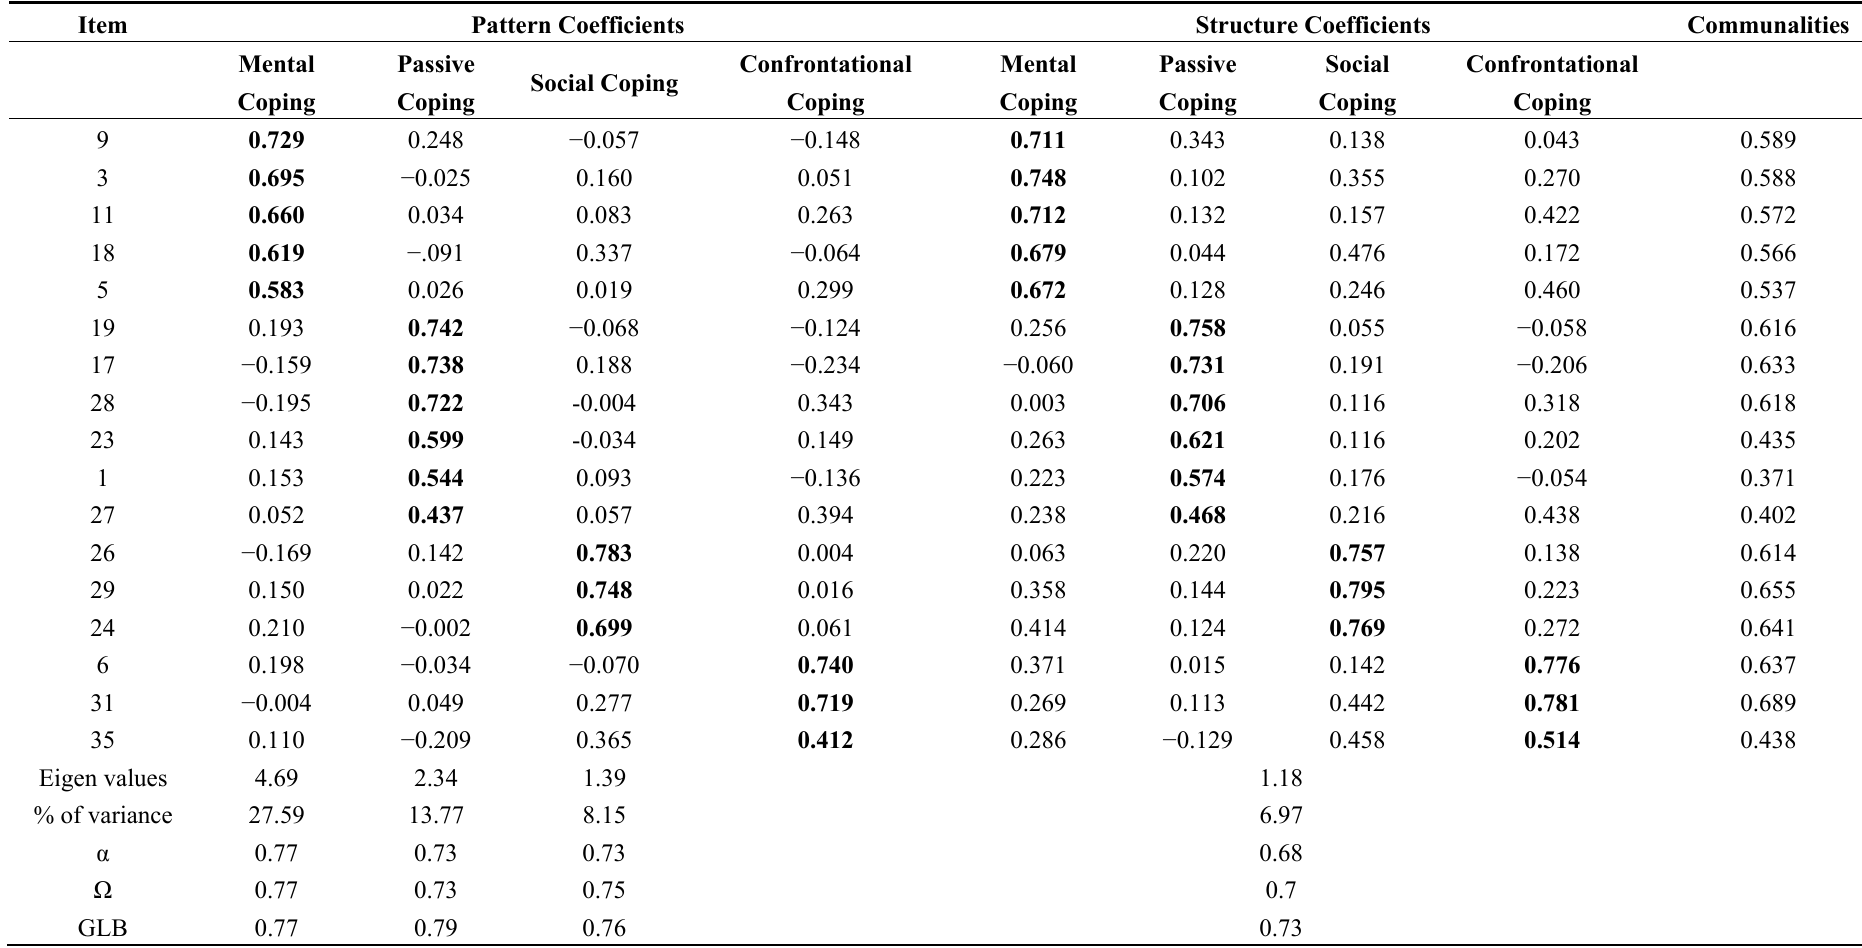
Table 3. Summary of exploratory factor analysis with direct oblimin rotation for the Cyberbullying Coping Questionnaire (CCQ) thoughts questionnaire (N =